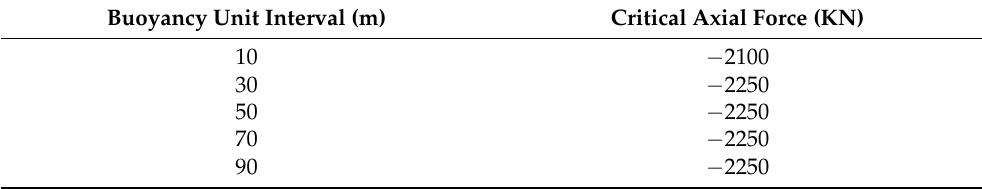
Table 8. Critical axial force of buoyancy unit interval.